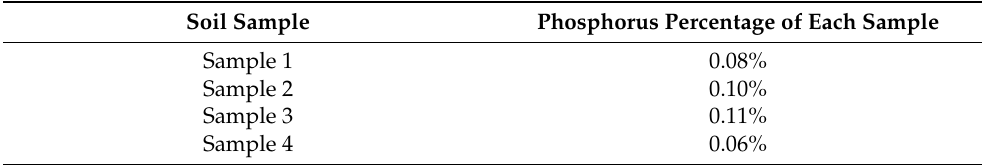
Table 4. The phosphorus percentage of the soil samples after 21 days decomposition of